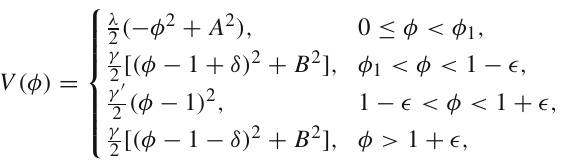
Fig. 2 a Potential V (φ) and b the kink solution with (cid:8)γ = 0 . 0. c , d Same as before with (cid:8)γ = 2 . 0 . Dashed lines (in grey) mark the limiting points in the definition of V (φ) and φ( x ) . Other parameters are: a , b γ = 3 . 0 (λ) . c , d γ = 3 . 0 (λ) and (cid:9) = 0 .